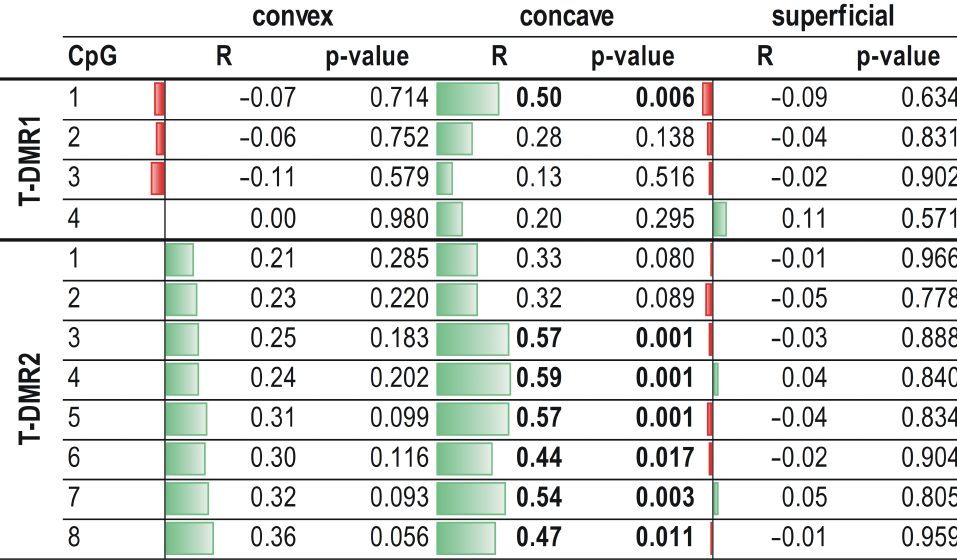
Figure 5. Correlation between ESR1 expression and methylation level within T-DMR1 and T-DMR2 regions in deep paravertebral muscles and superficial muscles. R—Spearman rank correlation